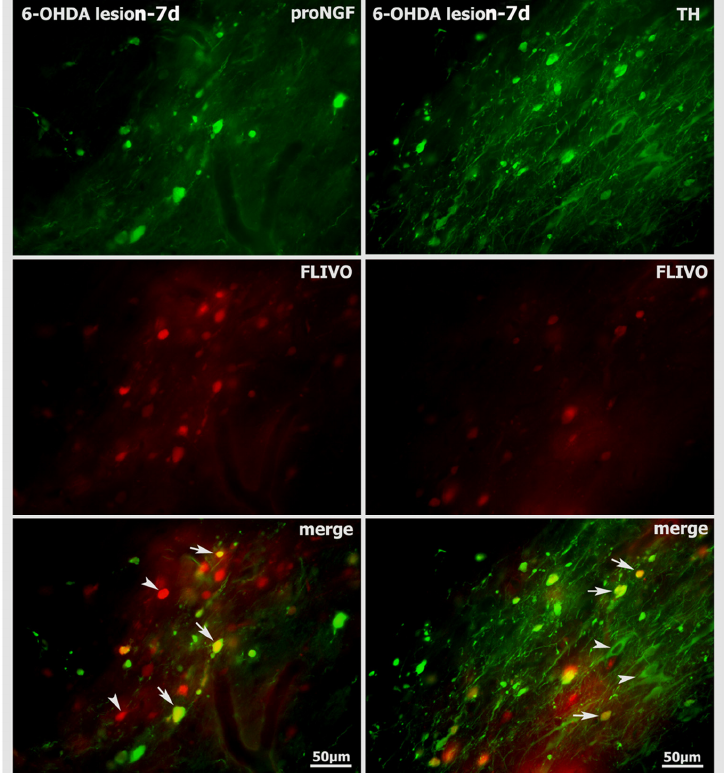
Figure 8. FLIVO staining shows neuronal cell death in the substantia nigra of 6-OHDA rat models. In the left column, proNGF-positive (green color), FLIVO-positive (red color, arrowheads) and FLIVO/TH double-labeled (yellow color, arrows) cells are shown. In the right column, TH-positive (green color, arrowheads), FLIVO-positive (red color) and FLIVO/TH double-labeled (yellow color, arrows) cells are